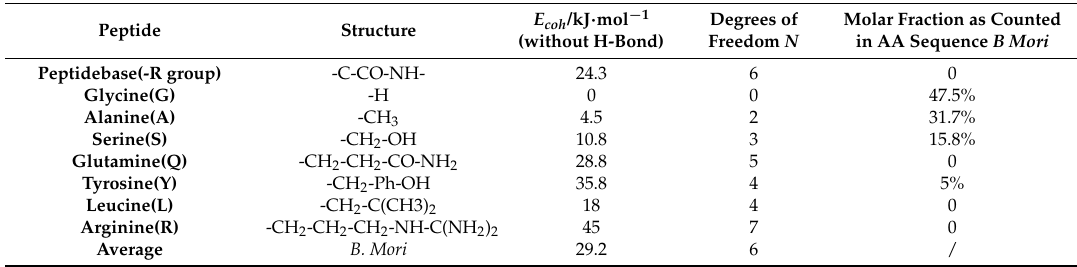
Table 3. Calculated GIM parameters based on peptide group contributions and amino acid (AA) sequences for B Mori silks